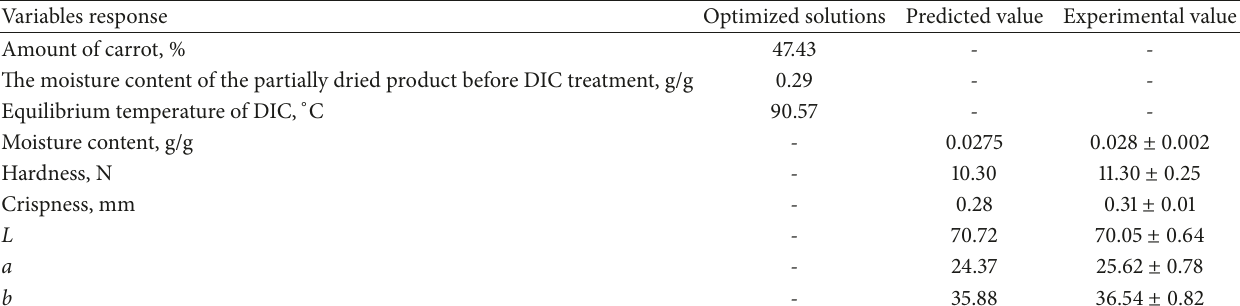
Table 5: Validation of predicted values for the qualities of the restructured chips.